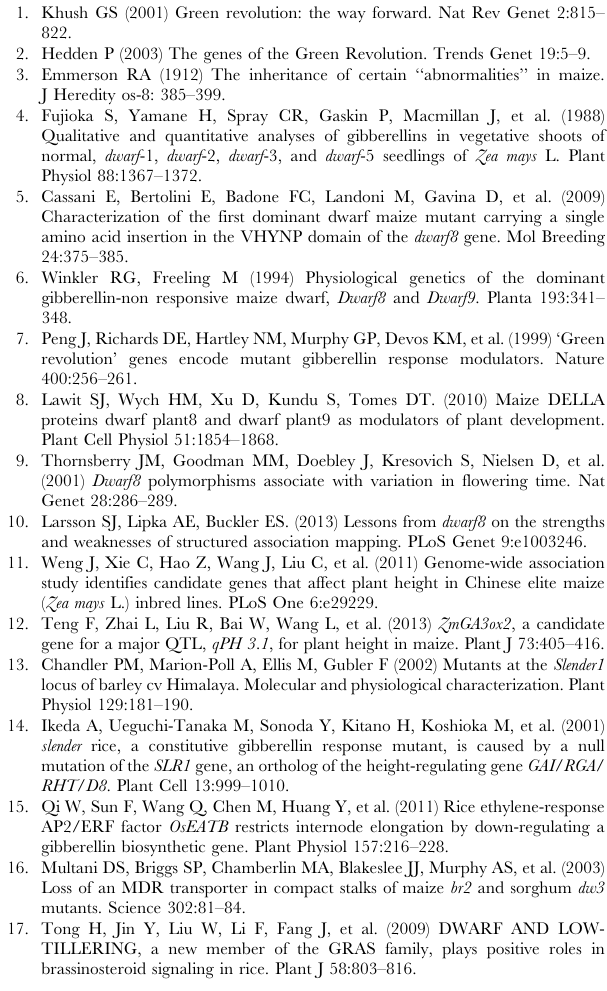
Table S2 Primers used in this study. Table S3 Detailed information of